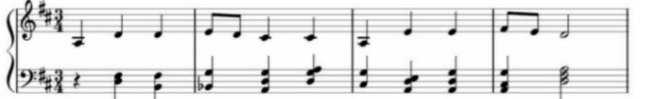
Figure 5. Musical notation from Figure 1, supplemented with the key signature determined using the proposed